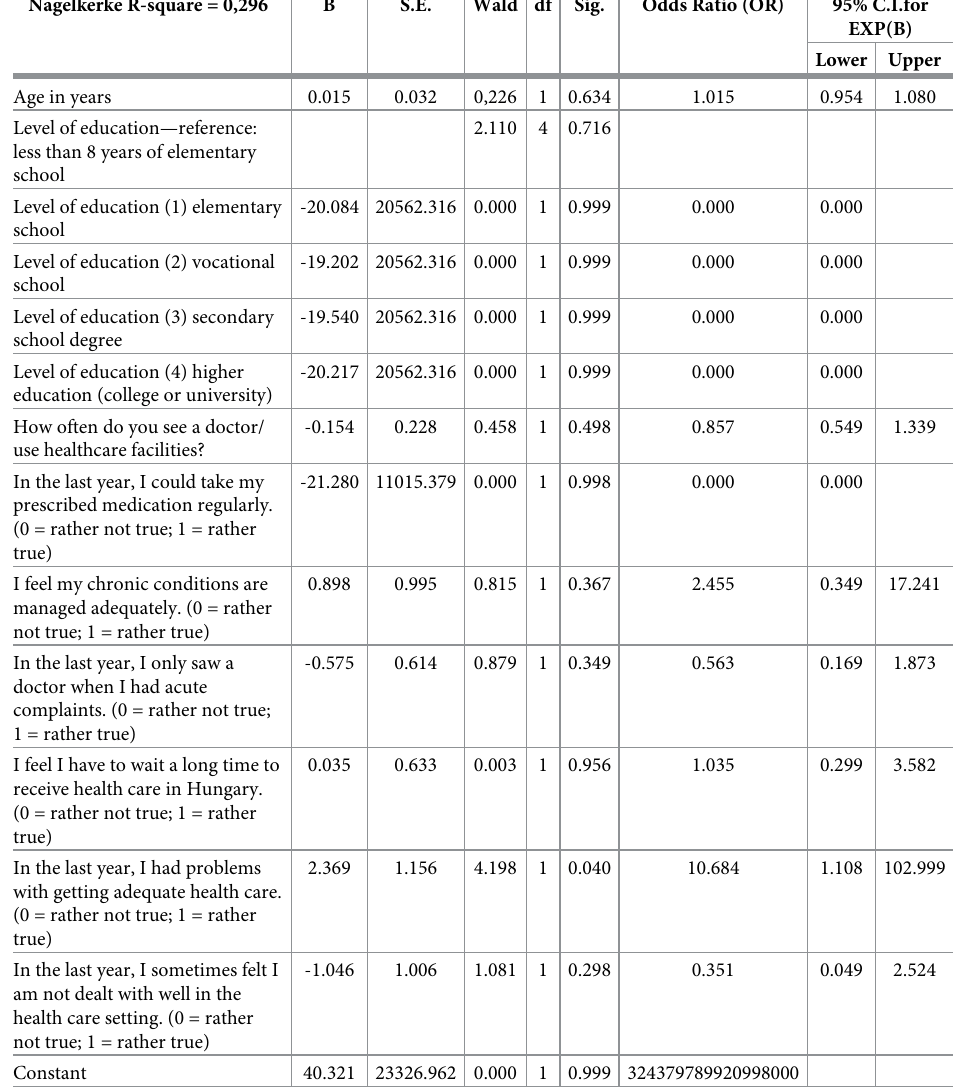
EXP(B) Lower Upper